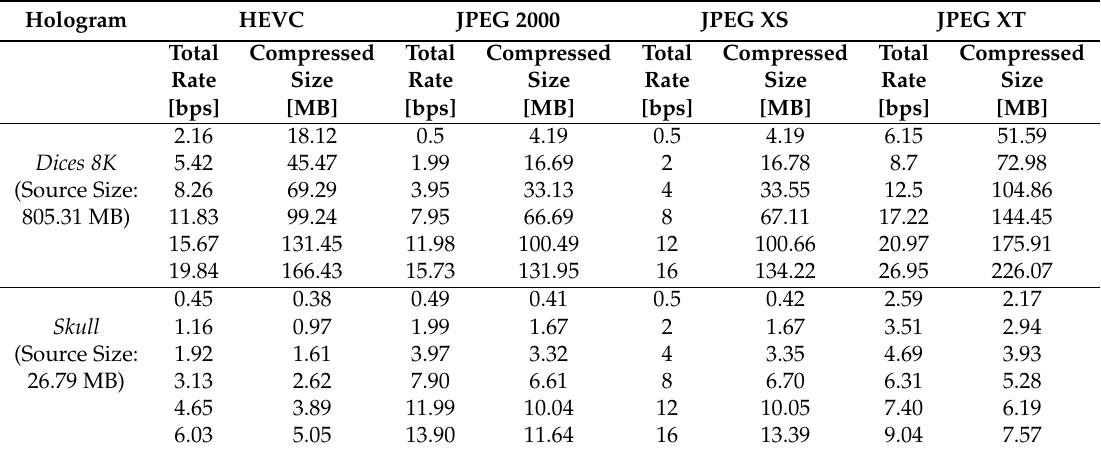
Table 1. Lossy compression